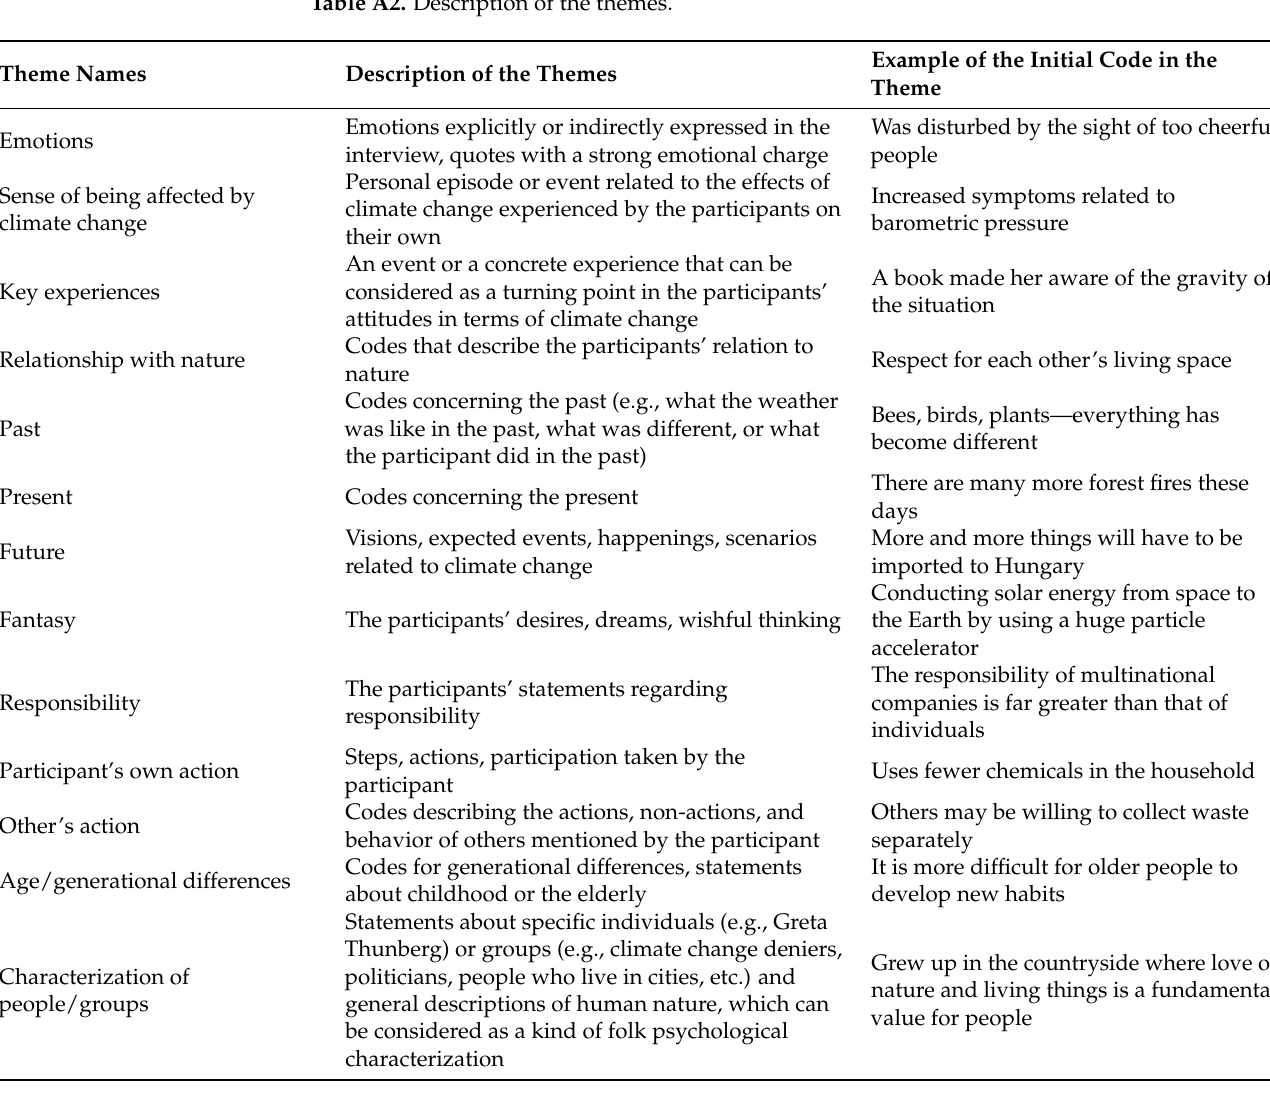
Table A2. Description of the